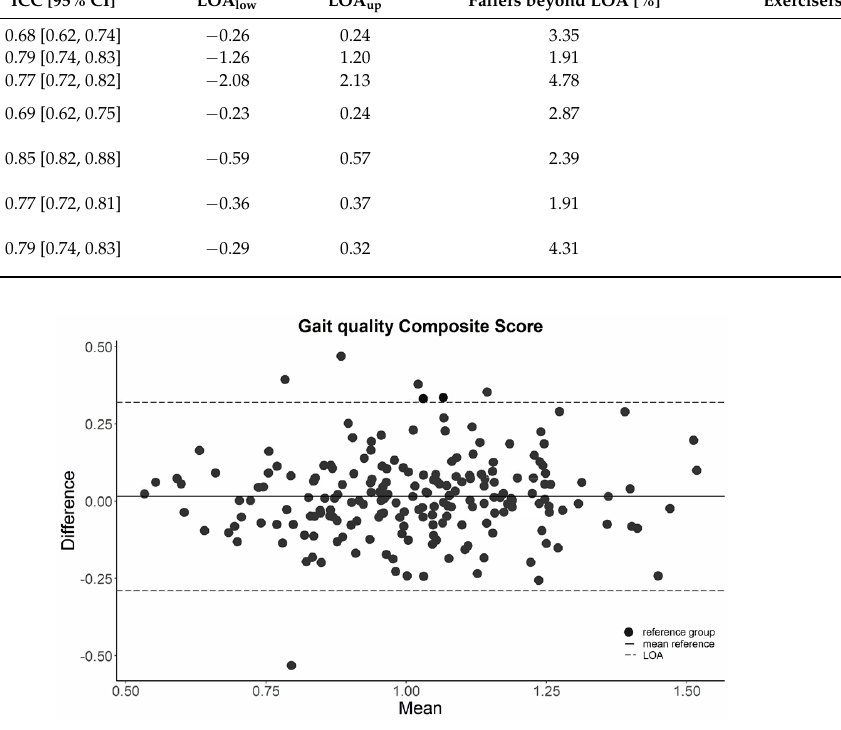
Figure 2. Bland–Altman plot of the gait quality composite score in the reference group. LOA = limit of agreement.